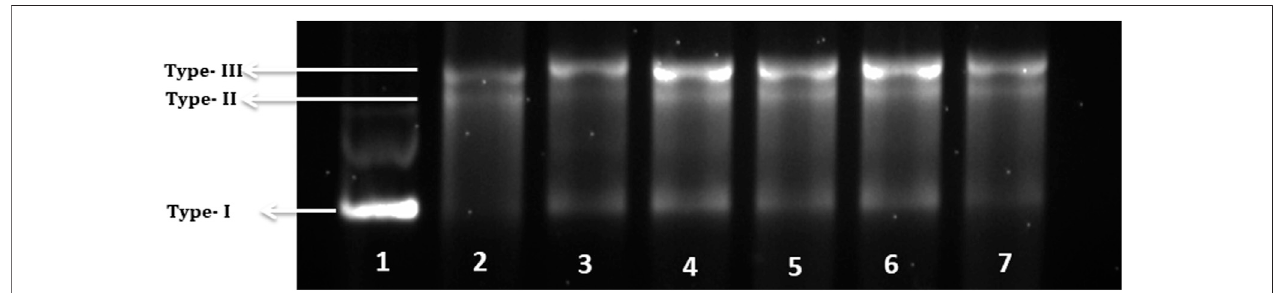
FIGURE 3 | DNA Nicking assay showing protective effect of PF70M extract against hydroxyl radical generated by Fenton ’ s reagent. Lane 1: Native plasmid DNA pBSKwithouttreatedwithFenton ’ sreagent;Lane2:DNAtreatedwithFenton ’ sreagent;Lane3:DNAtreatedwithFenton ’ sreactantand25 μ g/mlCurcumin;Lane4 –